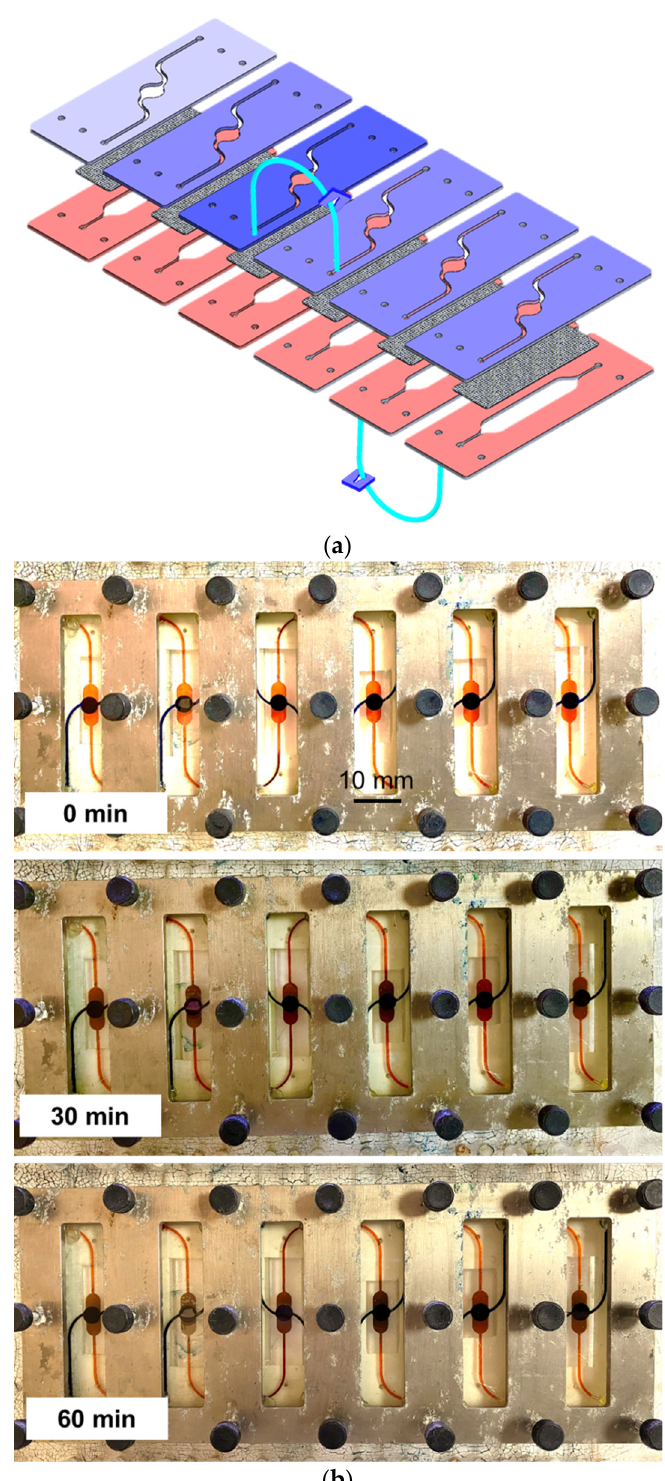
Figure 3. Fluidic routing through chip assembly. ( a ) Connection of the chip assembly, ( b ) images showing the color mixing due to the fluidic transfer through chips. showing the color mixing due to the fluidic transfer through